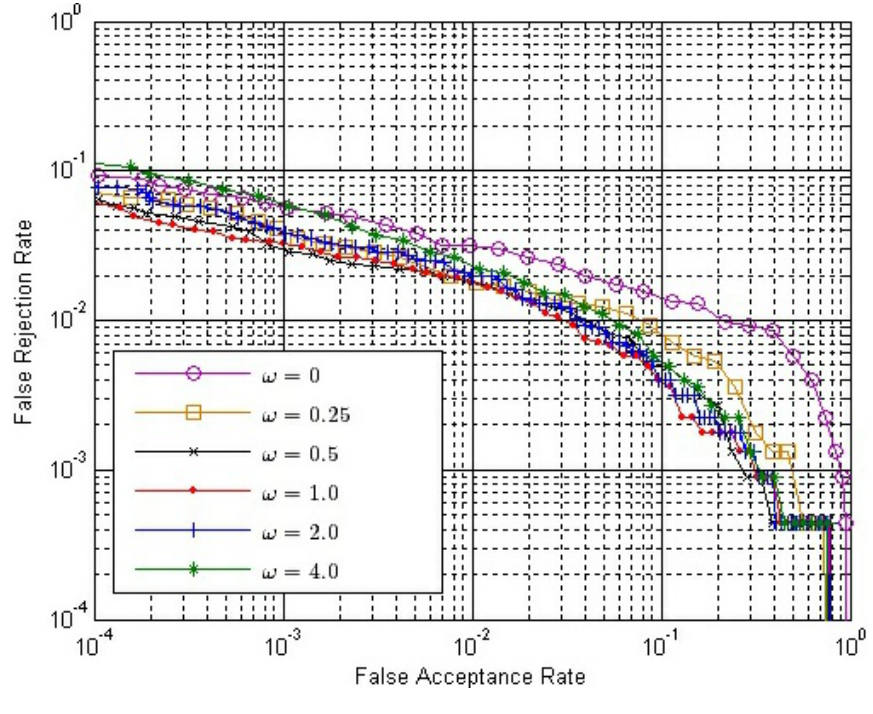
Figure 11. ROC of the final match score with different ω values, where both S E and S C are calculated by Strategy IS-2 and S O is calculated by Strategy